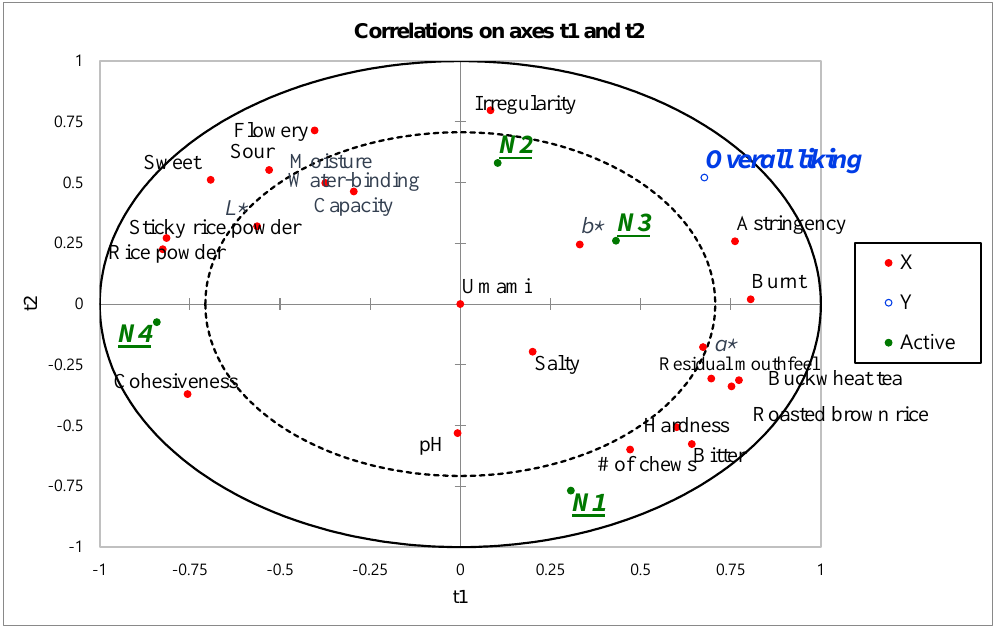
Figure 1. Partial least square regression on Nuroongji samples prepared with rice with different milling degree. N1 represents the Nuroongji made with unmilled brown rice; N2 represents Nuroongji made with 50% milled rice; N3 represents Nuroongji made with 70% milled rice; N4 represents Nuroongji made with white rice.